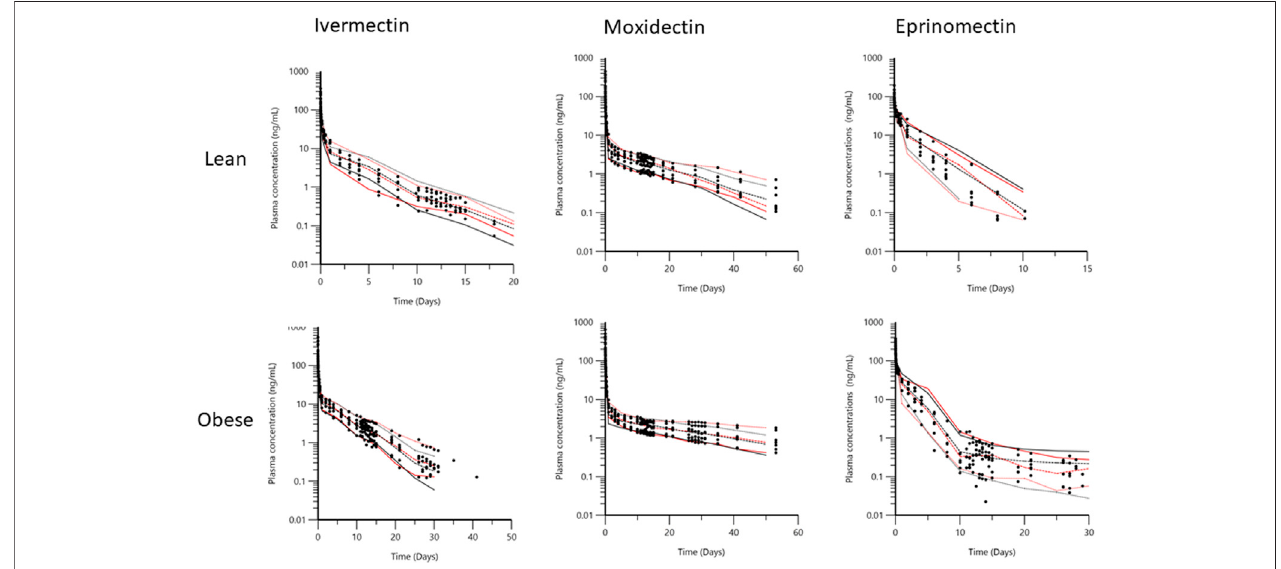
FIGURE 6 | Visual Predictive Check (VPC) obtained with 500 replicates of each dog and each status (lean, obese). For each strati fi cation, the observed quantiles (10, 50, and 90%) were well super-imposed with the corresponding predictive check quantiles over the observed data. Red lines: observed quantiles; Black lines: predicted quantiles; Black symbols: observed data.